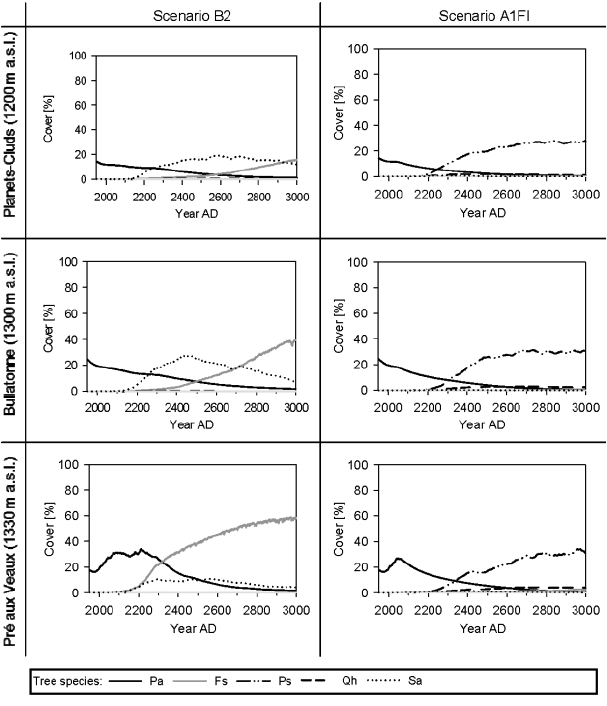
Fig. 9 . Tree species shift following climate change in the wooded pastures Planets-Cluds, Bullatonne, and Pré aux Veaux (m a.s.l. = meters above sea level). The pasture Rionde was not simulated for being at the same altitude as Pré aux Veaux. Species not occurring during the simulations are not displayed. Species abbreviations: Pa: Picea abies ; Fs: Fagus sylvatica ; Ps: Pinus sylvestris ; Qh: Quercus pubescens ; Sa: Sorbus aucuparia